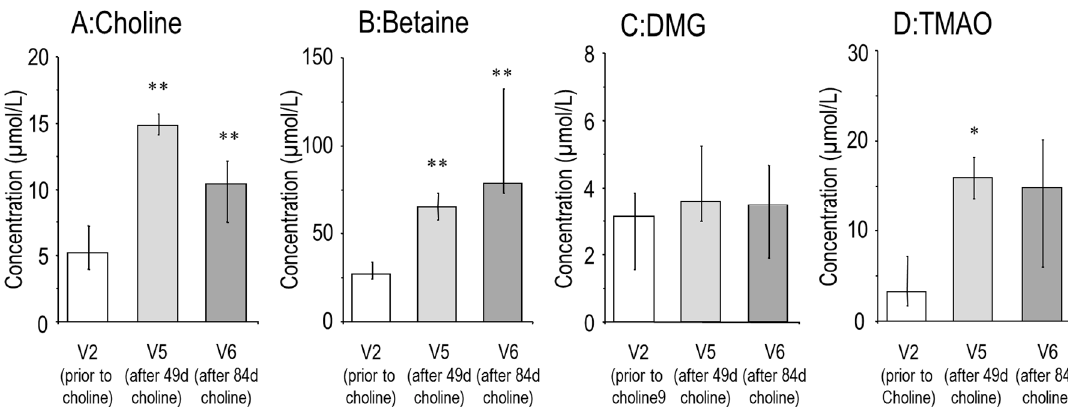
Figure 1. Effect of oral choline supplementation on the plasma concentration of choline ( A ) and its water-soluble metabolites betaine, dimethylglycine (DMG) and trimethylamine oxide (TMAO) ( B–D ). Bars represent values prior to (visit [V] 2), after 49 (45–51) days (V5) and after 84 (84–91) days (V6) supplementation with 3 × 1 g choline chloride. Data are medians and interquartile ranges of CF patients prior to (V2), and after 49 (45–51) days (V5) and 84 (84–91) days (V6) choline supplementation. * p < 0.05; ** p < 0.01 vs. V2.